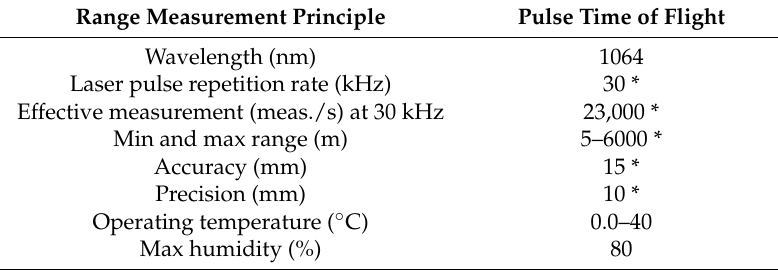
Table 2. Characteristics of the VZ-6000 laser scanner (modified according to Riegl